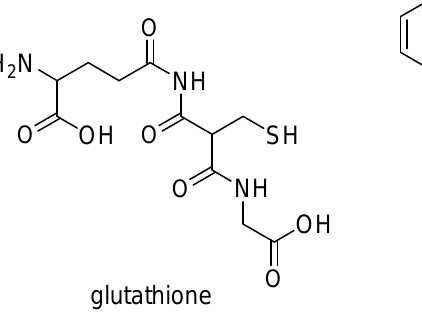
Figure 7. Diester prodrug of glutathione derivative with antileishmaniasis